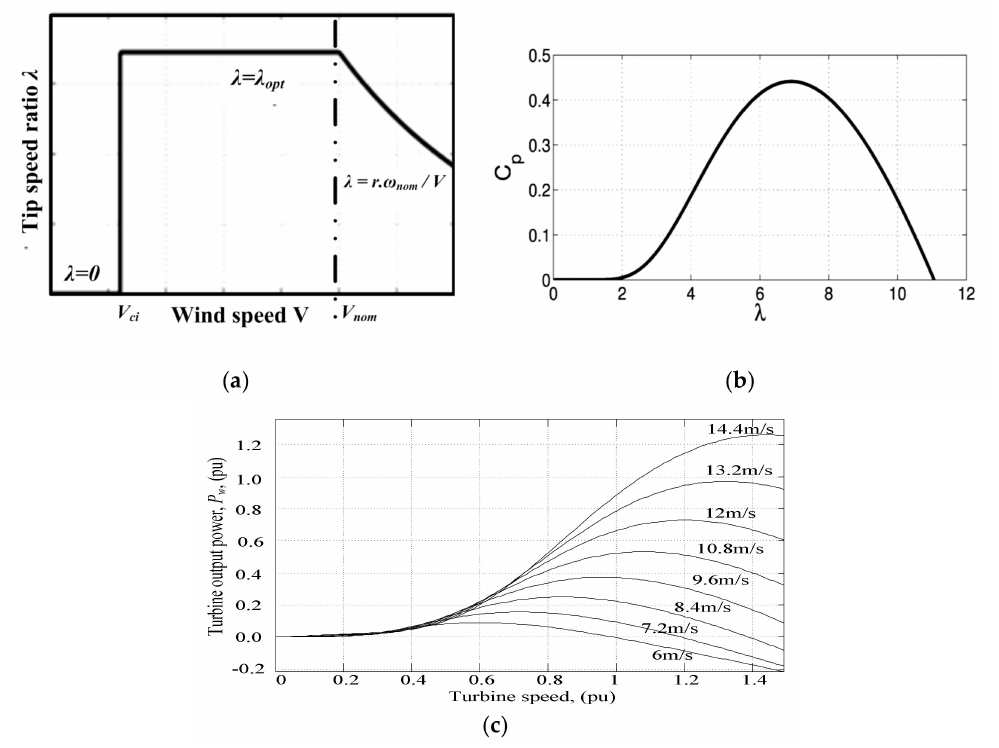
Figure 2. Wind turbine curves ( a ) Ideal λ versus V curve, ( b ) common C p ( λ ) curve, and ( c ) Turbine output power versus generator speed at di ff erent wind speeds, at β =